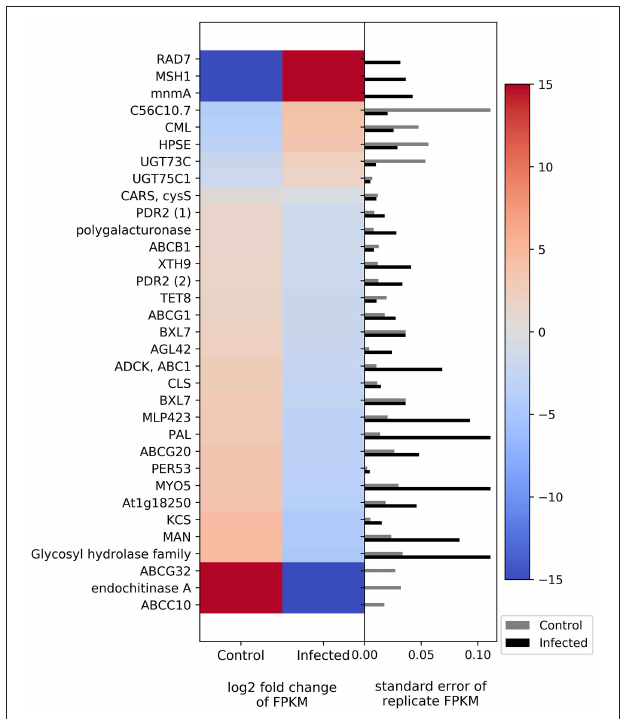
FIGURE 3 | Heatmap of DEGs related to defense. The left side of the plot is the heatmap of log2 fold change of FPKM between all infected and uninfected groups. The right side of the plot is the standard error for all replicates divided by the average FPKM for the uninfected and infected groups. See Supplemental Table 2 for gene names associated with all